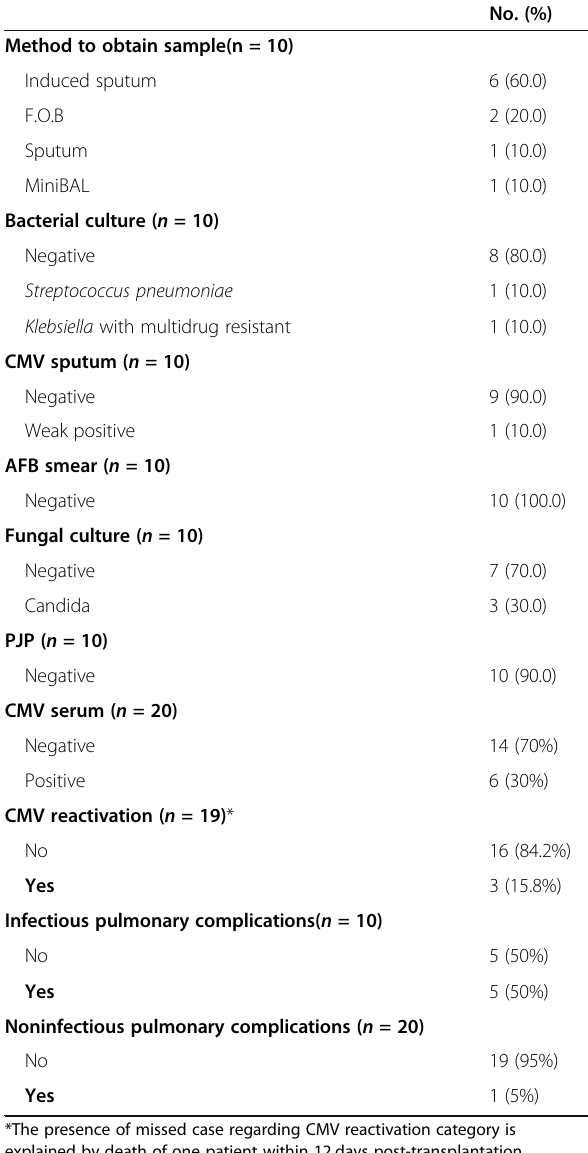
F.O.B fiber optic bronchoscopy, CMV cytomegalovirus, AFB acid fast bacilli, PJP Pneumocystis jiroveci